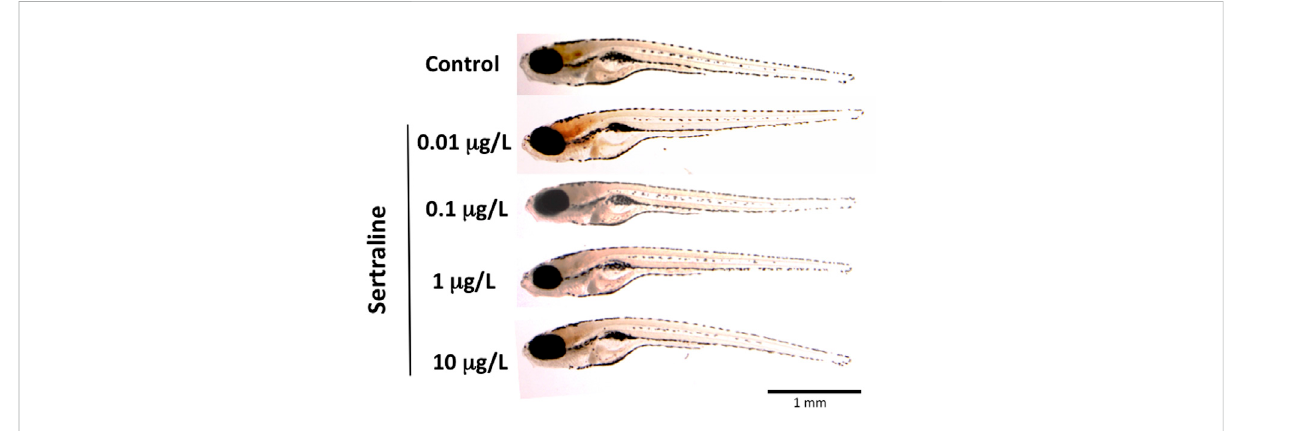
FIGURE 2 Representative zebra fi sh larvae (8dpf) following developmental exposure to different concentrations of SER. Lateral view.